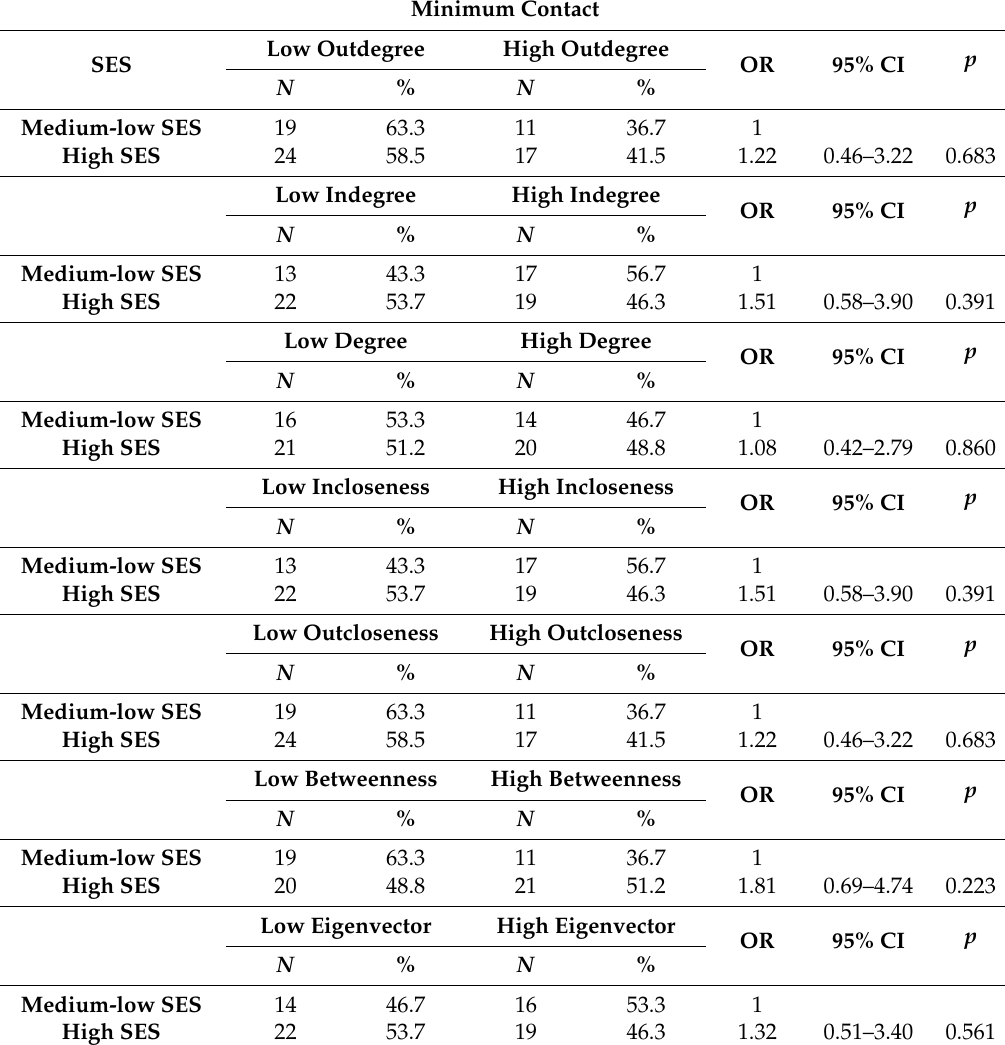
Table 4. Estimation of probability of the relationship between SES in the overweight adolescent and network parameters, at the minimum contact intensity